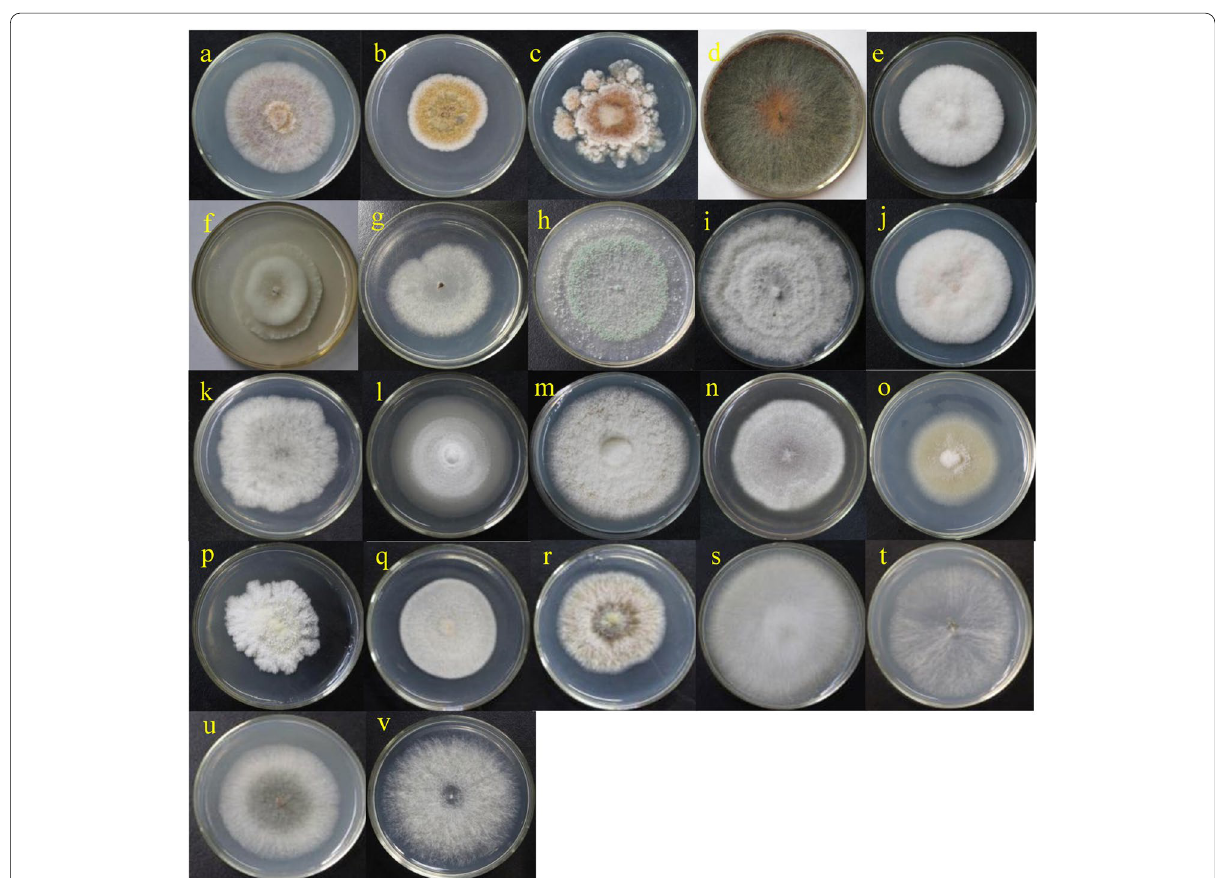
Fig. 1 Front views of the colonies of endophytic fungi isolated from B . polyandra . a ~ v Bpf-1 to Bpf-22,